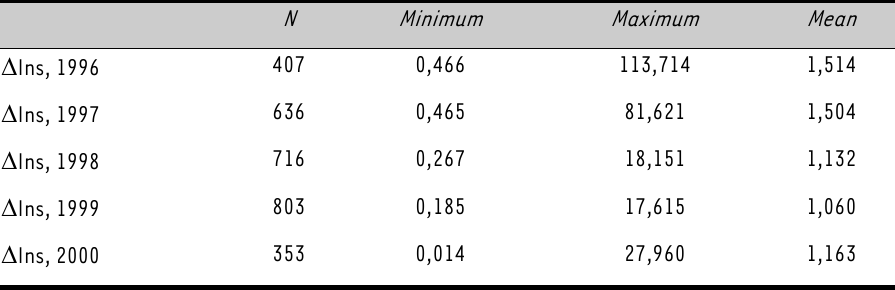
TABLE 2: Descriptive statistics - change in institutional ownership